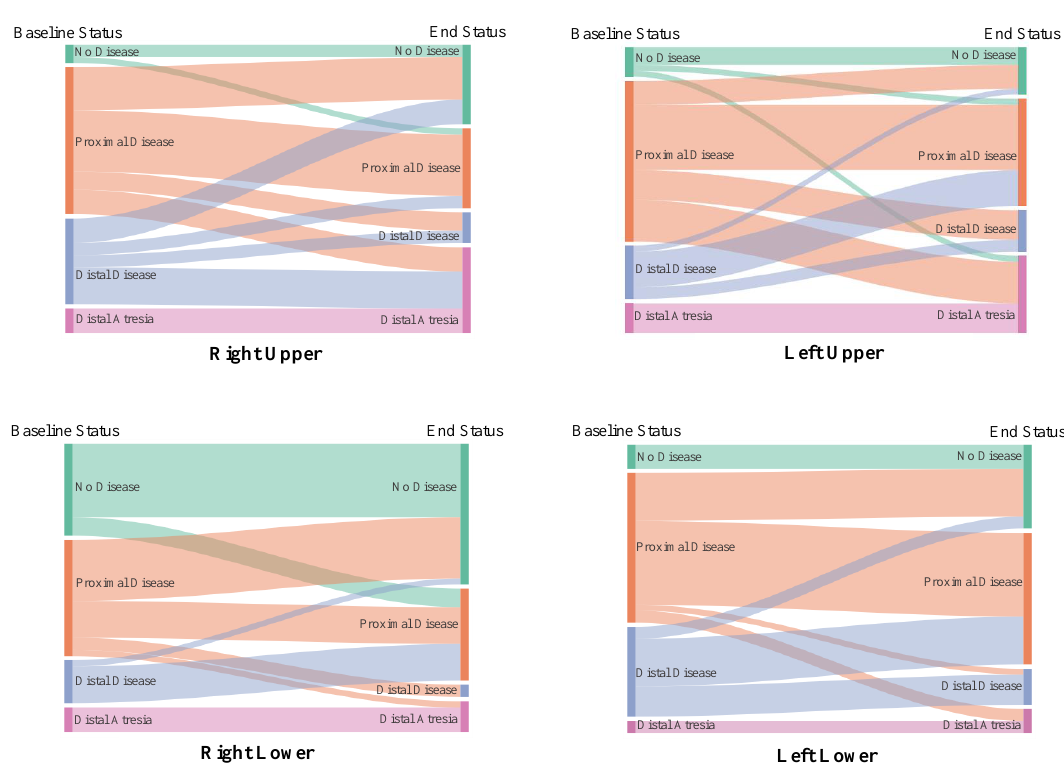
Figure 2. Change in disease status by pulmonary vein location, baseline to study